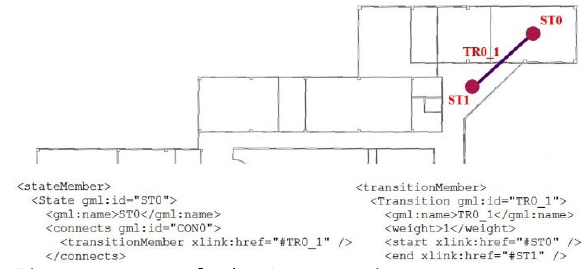
Figure 4. Concept of IndoorGML mapping